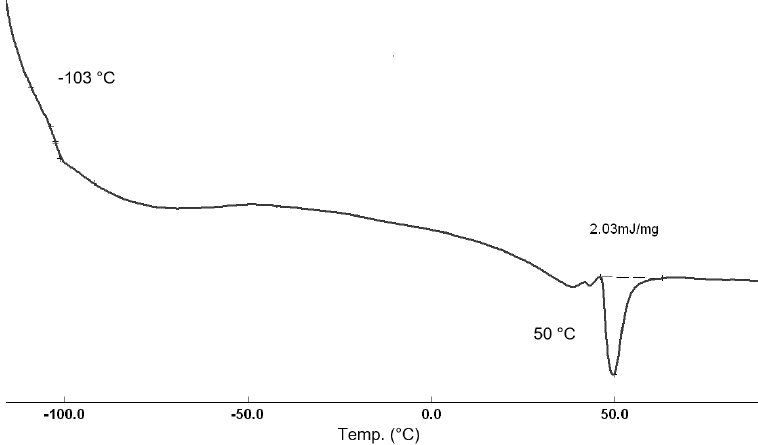
Figure 6. Differential scanning calorimetry (DSC) trace of stereoblock polybutadiene synthesized in Run